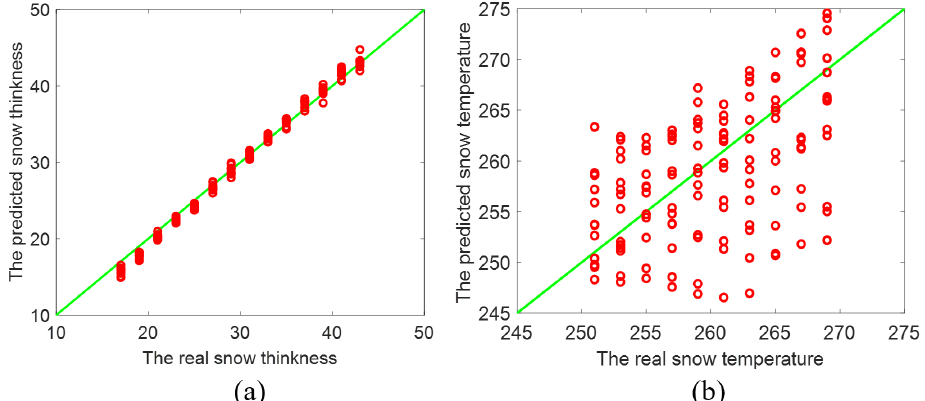
Figure 6. Inverted result of ( a ) the thickness and ( b ) the temperature of the snowpack by the SVM method